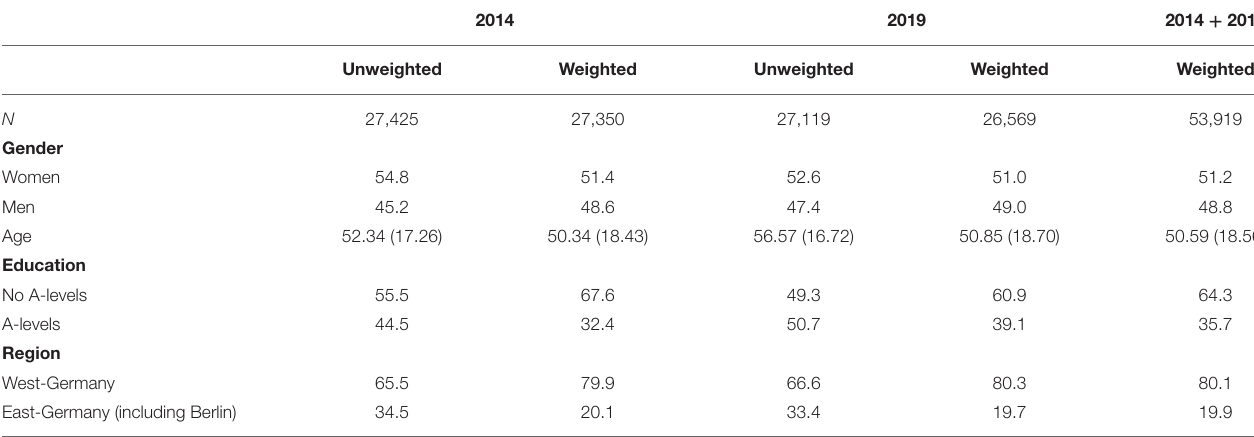
TABLE 2 | Description of the overall sample.